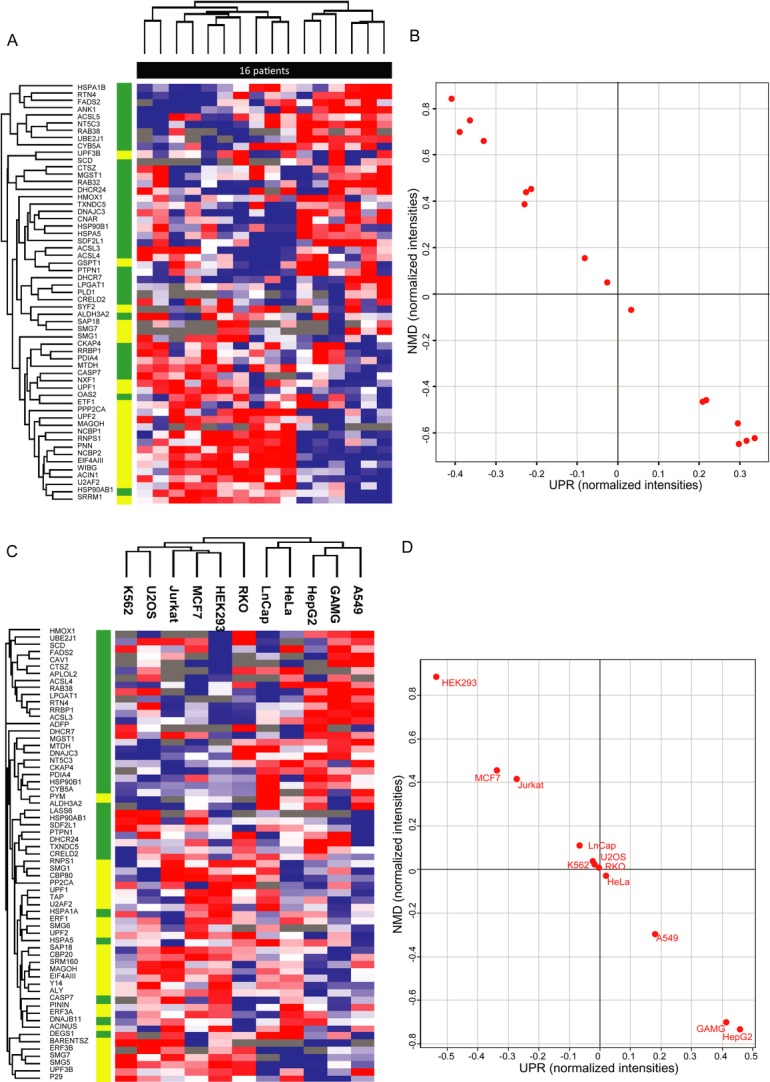
A negative correlation between NMD and UPR factors.A–D Hierarchical clustering (A, C) and scatter plots (B, D) of 58 NMD and UPR factors in 16 primary lymphocytes from CF patients (A, B) and commonly used cell lines (Geiger et al, 2012) (C, D). For the scatter plots, we averaged the normalized ratio values (primary lymphocytes) or normalized intensities (cell lines) of each group of proteins (NMD or UPR).